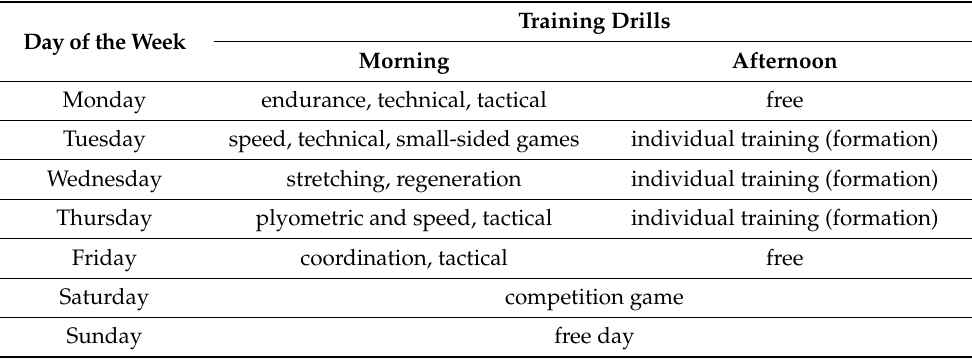
Table 1. Overview of the typical weekly training load during